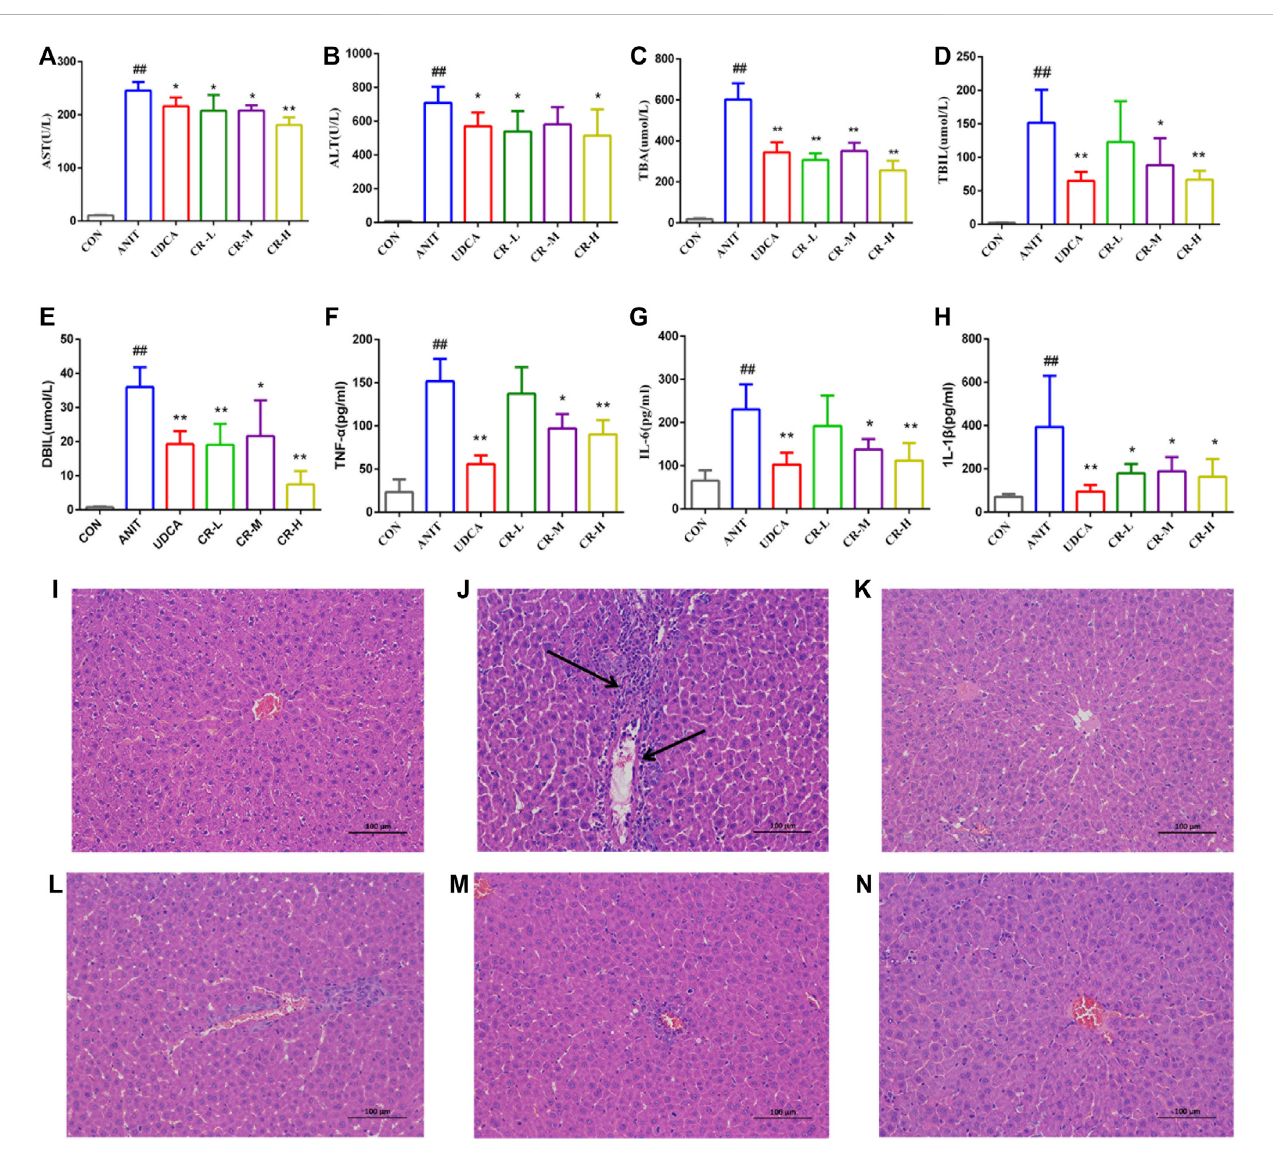
FIGURE 3 Effect ofcrocin Ionserum biochemicalindexesand histological (H&Estained, 100× magni fi cation).Hepatocytedamage isindicatedbyblack arrows. (A) SerumASTlevel, (B) serumALTlevel, (C) serumTBAlevel, (D) serumTBILlevel, (E) serumDBILlevel, (F) serumTNF- α level, (G) serumIL-6level, (H) serumIL-1 β level, (I) CON group, (J) ANIT group, (K) UDCA group, (L) CR-L group, (M) CR-M group, (N) CR-H group. Data are presented as means ± SD (n = 6). # p < .05, ## p < .01 compared with the CON group; * p < .05, ** p < .01 compared with ANIT